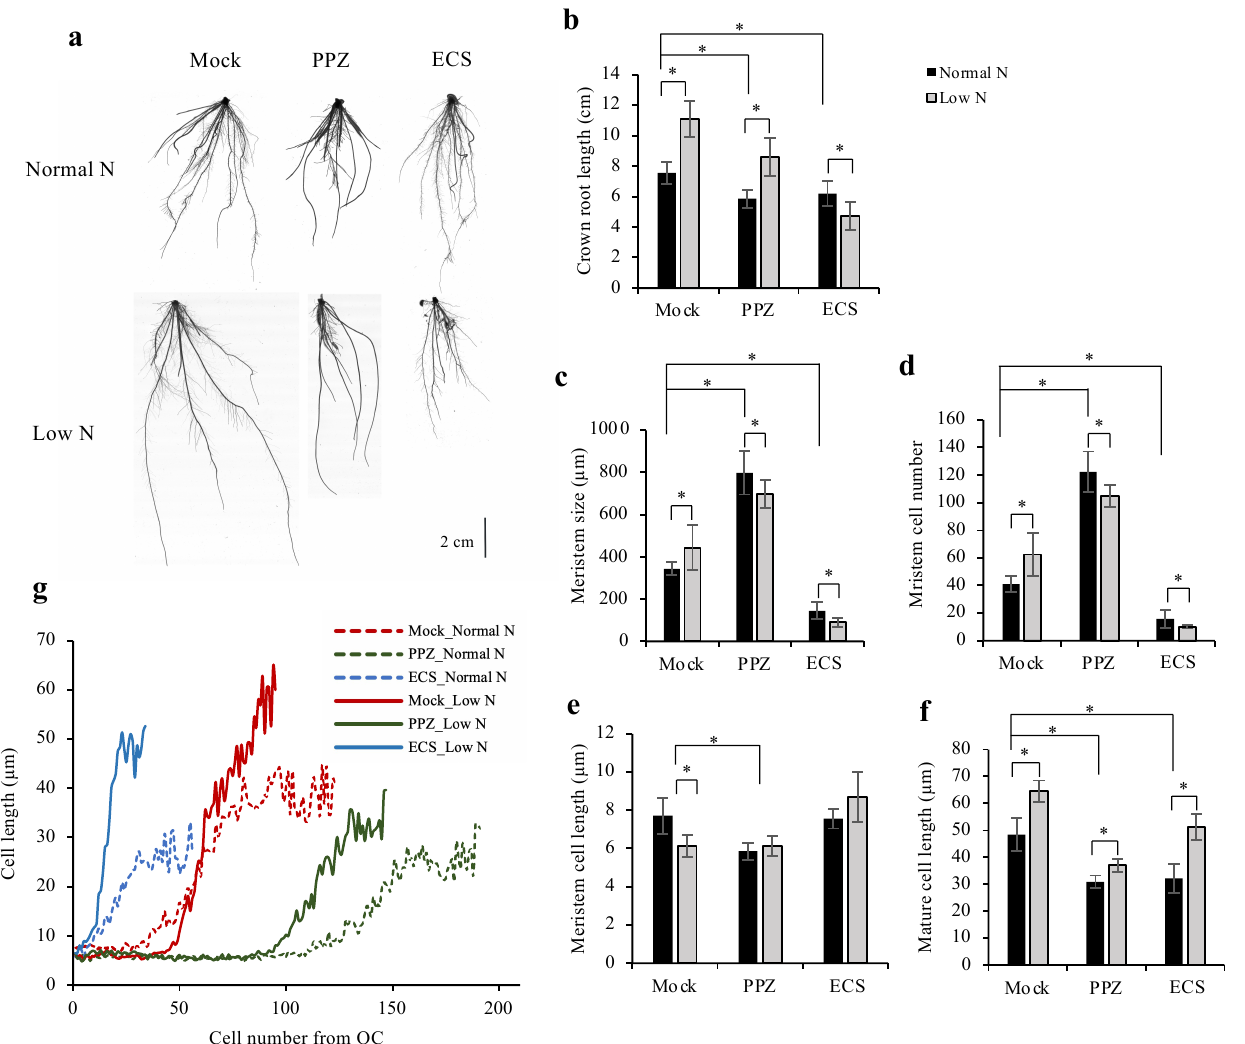
Figure 5. Effect of ECS and PPZ treatments on root growth responses to N deficiency. Germinated seeds were grown in normal N for 5 d and then transferred to either normal N or low N conditions containing 10 nM ECS or 4 µ M PPZ or mock for 7 d. ( a ) Representative images of roots grown under different treatments. Scale bar = 2 cm. ( b ) Crown root length was calculated from the average of the three longest crown roots. Data are means ± SD ( n = 10 biological replicates). ( c – g ) Quantifications of root meristem size ( c ), meristem cell number ( d ) and average meristem cell length ( e ) in the crown roots were determined from cortical cells in the 4th cortical layer by measuring from the QC to the first elongated cell. Mature cell length ( f ) was determined from the average length of five adjacent mature cortical cells. ( g ) Average cortical cell length along the longitudinal root axis from the QC illustrated the number of cells in the meristem, the onset of rapid cell elongation and the effect of low N on promoting cell elongation under mock and ECS treatments but not PPZ treatment. Data are means ± SD ( n ≥ 6 biological replicates). Significant differences are indicated by * for p <